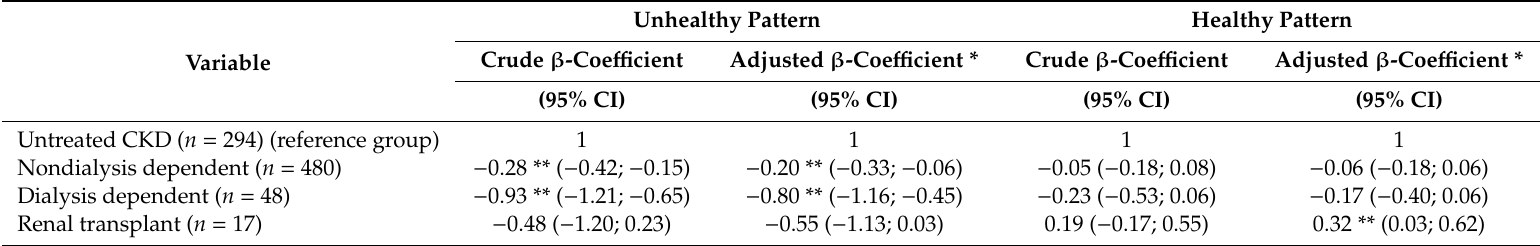
Table 5. Linear regression models (crude and adjusted) for the association between CKD treatment and mean scores of dietary patterns in individuals with CKD from the Brazilian NHS, 2013 ( n =